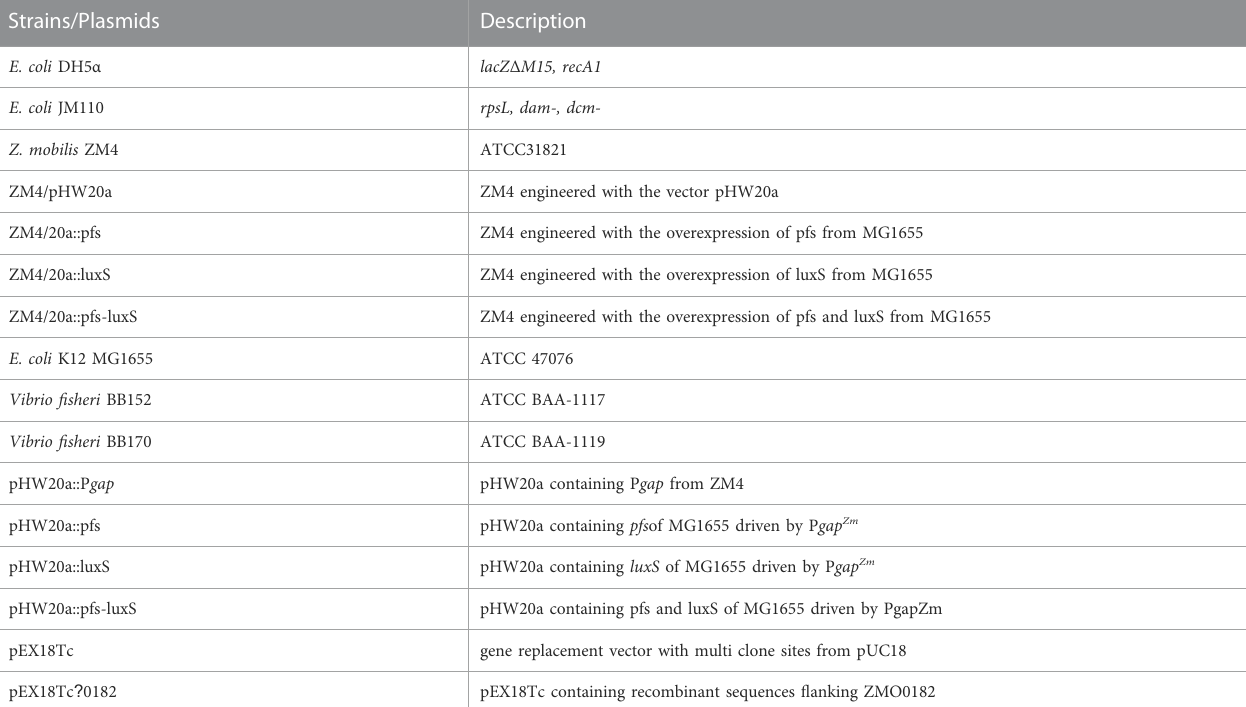
TABLE 1 Plasmids used in this work. Strains/Plasmids Description